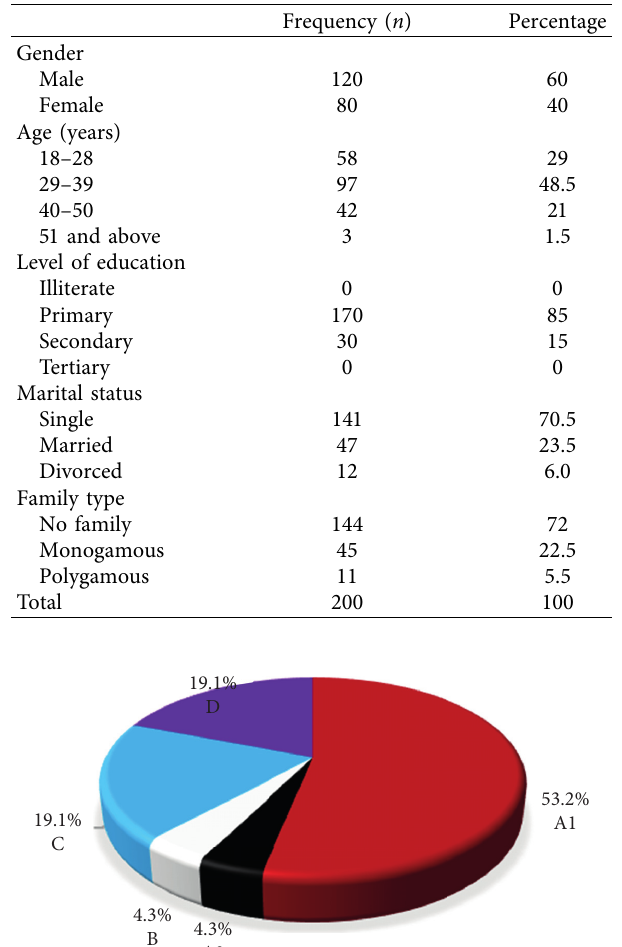
Table 1: Demographic information of the study participants.